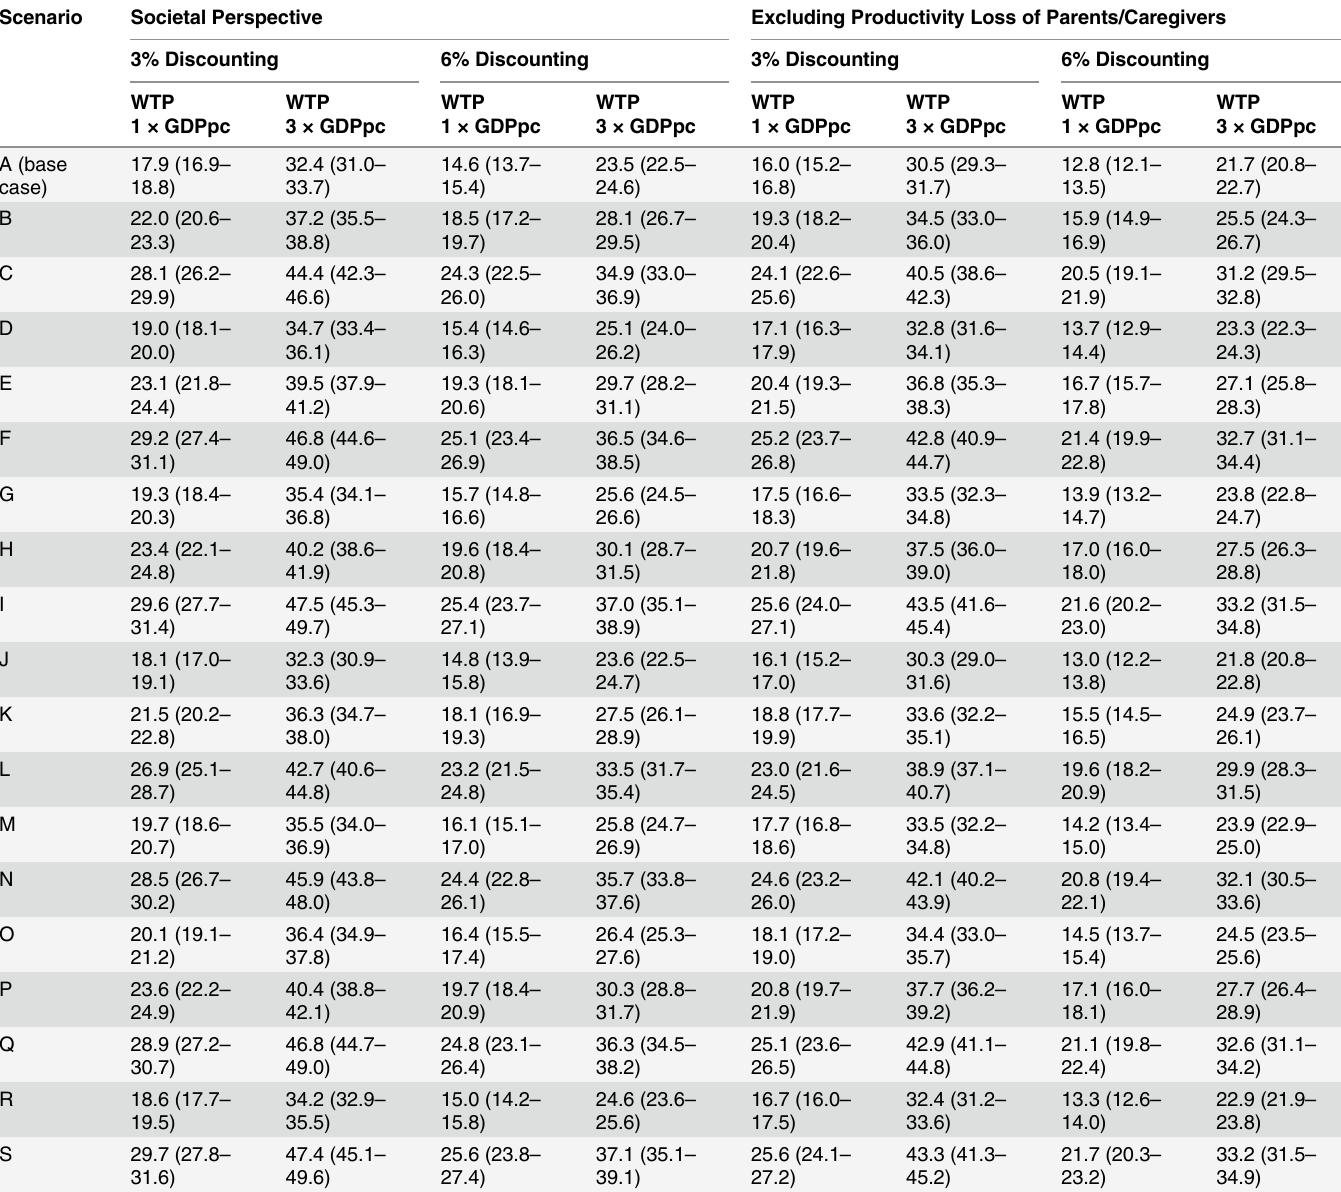
Table 2. Cost-effectiveness ceiling on effective vaccine cost if all EV71-HFMD cases were registered by the national HFMD